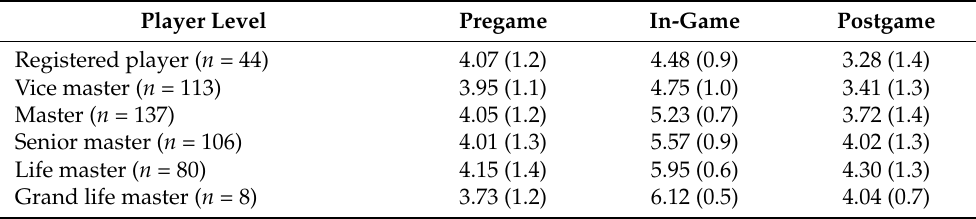
Table 3. Means and standard deviations of the Bridge Cognitive Strategies